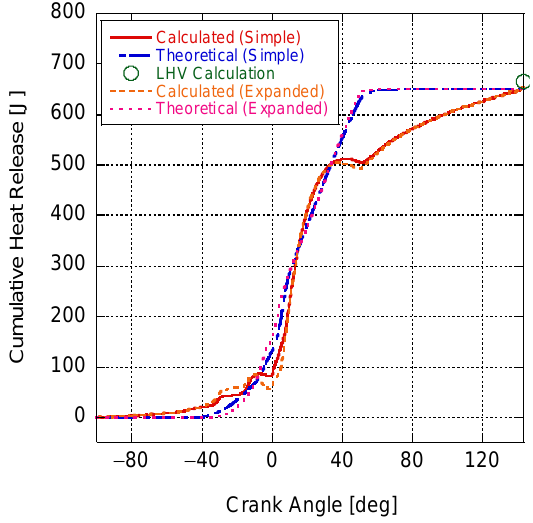
Figure 8. Cumulative heat release calculated based on the first law, from theory, and the final value according to the lower heating values. The figure provides the results from the singular localized combustion reactions (simple) and the expanded combustion reactions (expanded).